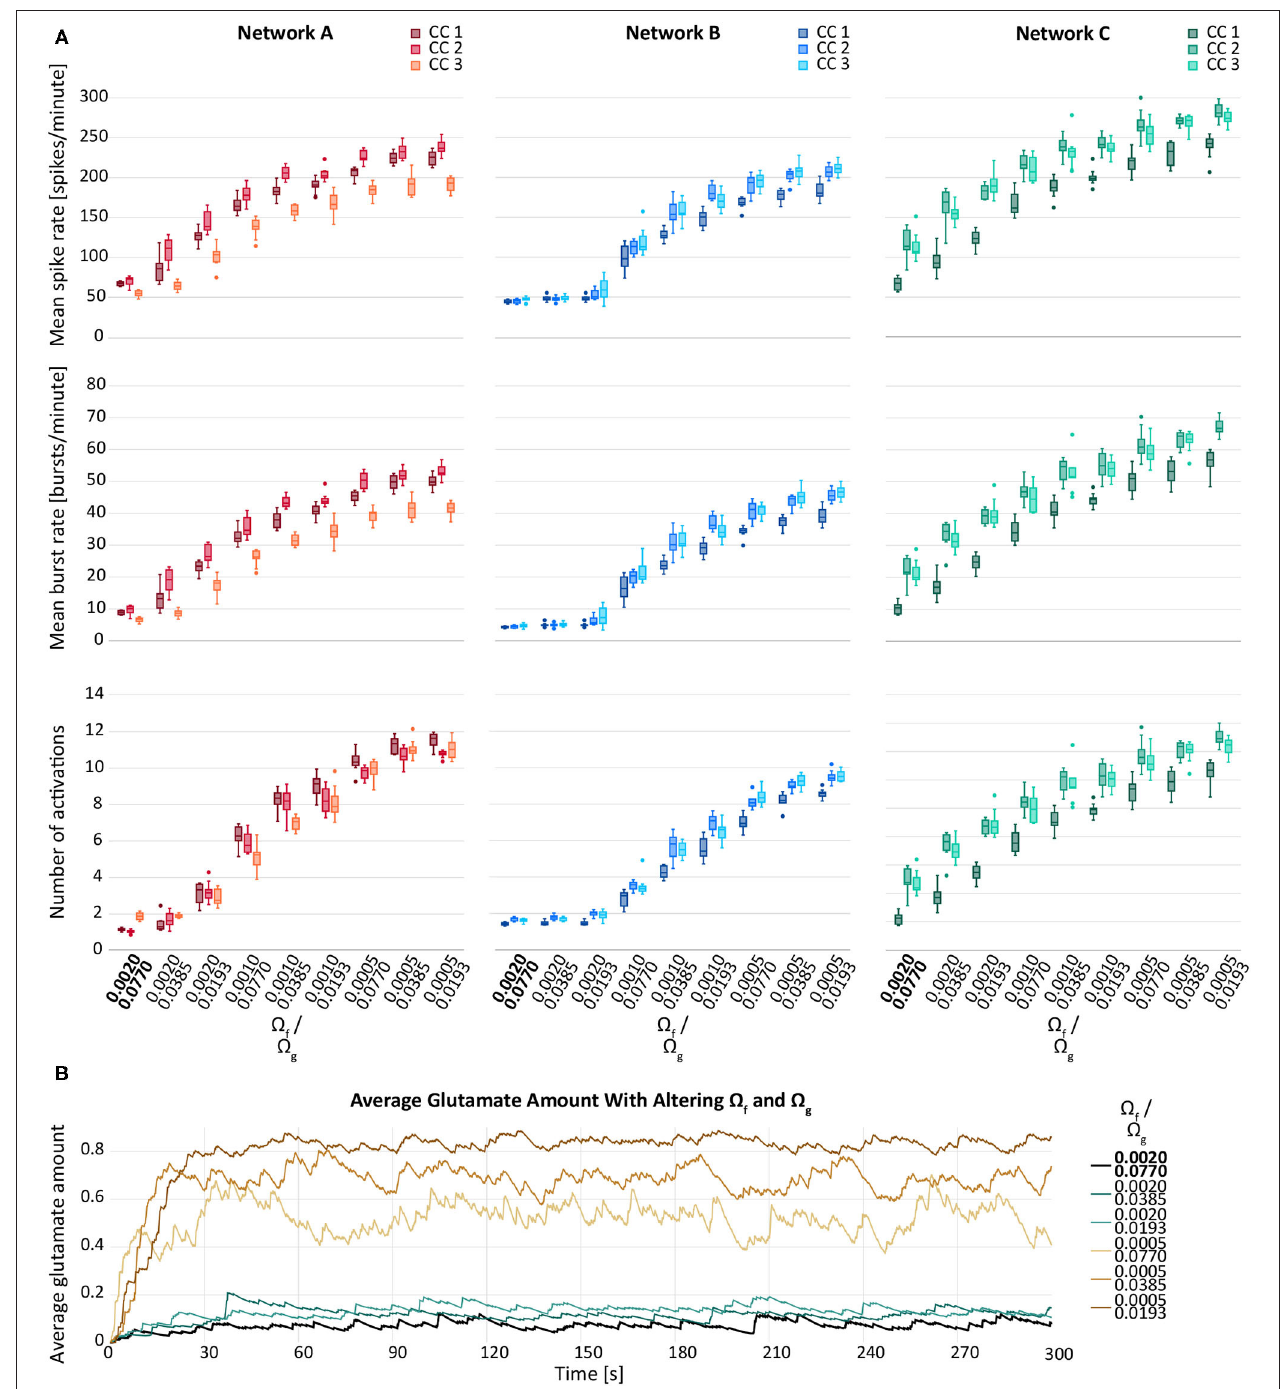
FIGURE 4 | (A) Mean spike rate (top), mean burst rate (middle) and mean number of activations per astrocyte (bottom) for varying rates of synaptic facilitation, (cid:127) g , and varying recovery rates of the gliotransmitter receptors, (cid:127) g , for networks A–C and their connectivity configurations CC 1 , 2 , 3 . The default values are indicated in bold. (B) Average glutamate amount in astrocytes when varying the synaptic facilitation rate, (cid:127) g , and the recovery rate of the gliotransmitter receptors, (cid:127) g . The black line resembles the baseline activity from network B, CC 1 . The brown lines represent the changes by (cid:127) f and the blue lines the changes by (cid:127) g . number of inhibitory cells in the networks. Moreover, compared alterations of Y + was higher than the inter-network and max = − 0.7 to the unmodified parameter configuration ( Y − the inter-connectivity variance. This was not the case for the max = 0.7), the response variables from the distorted and Y + variance induced by deviating Y − , which was due the lower max max